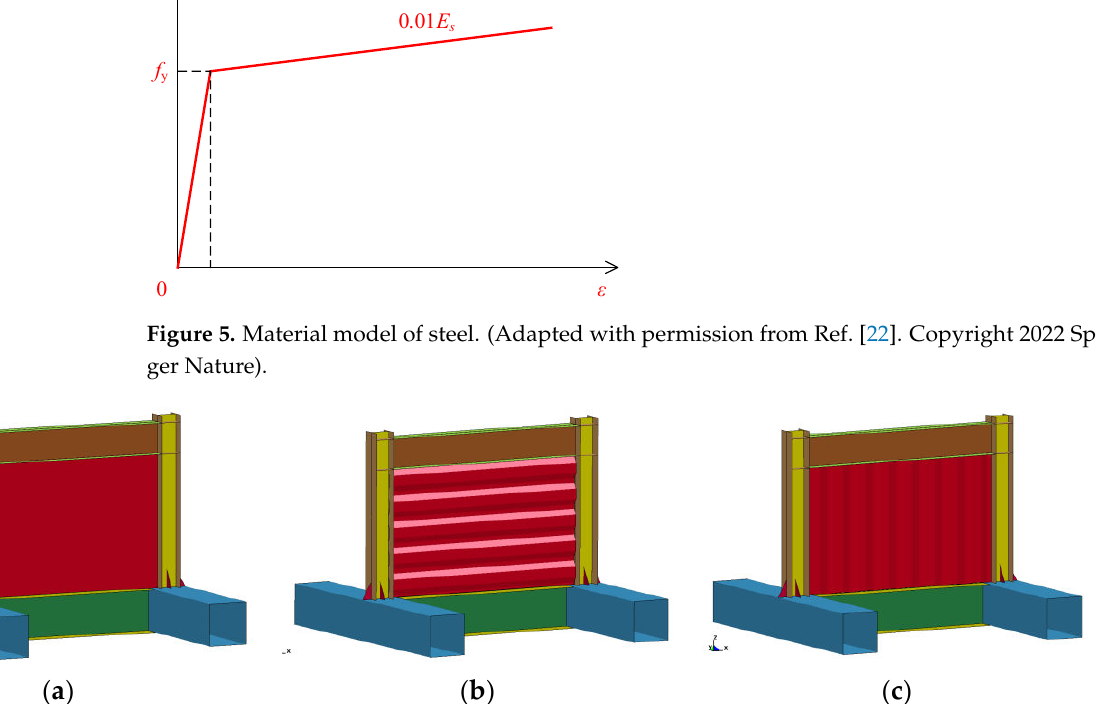
Figure 6. Simulated walls with ( a ) flat, ( b ) horizontal corrugated, and ( c ) vertical corrugated steel plate.